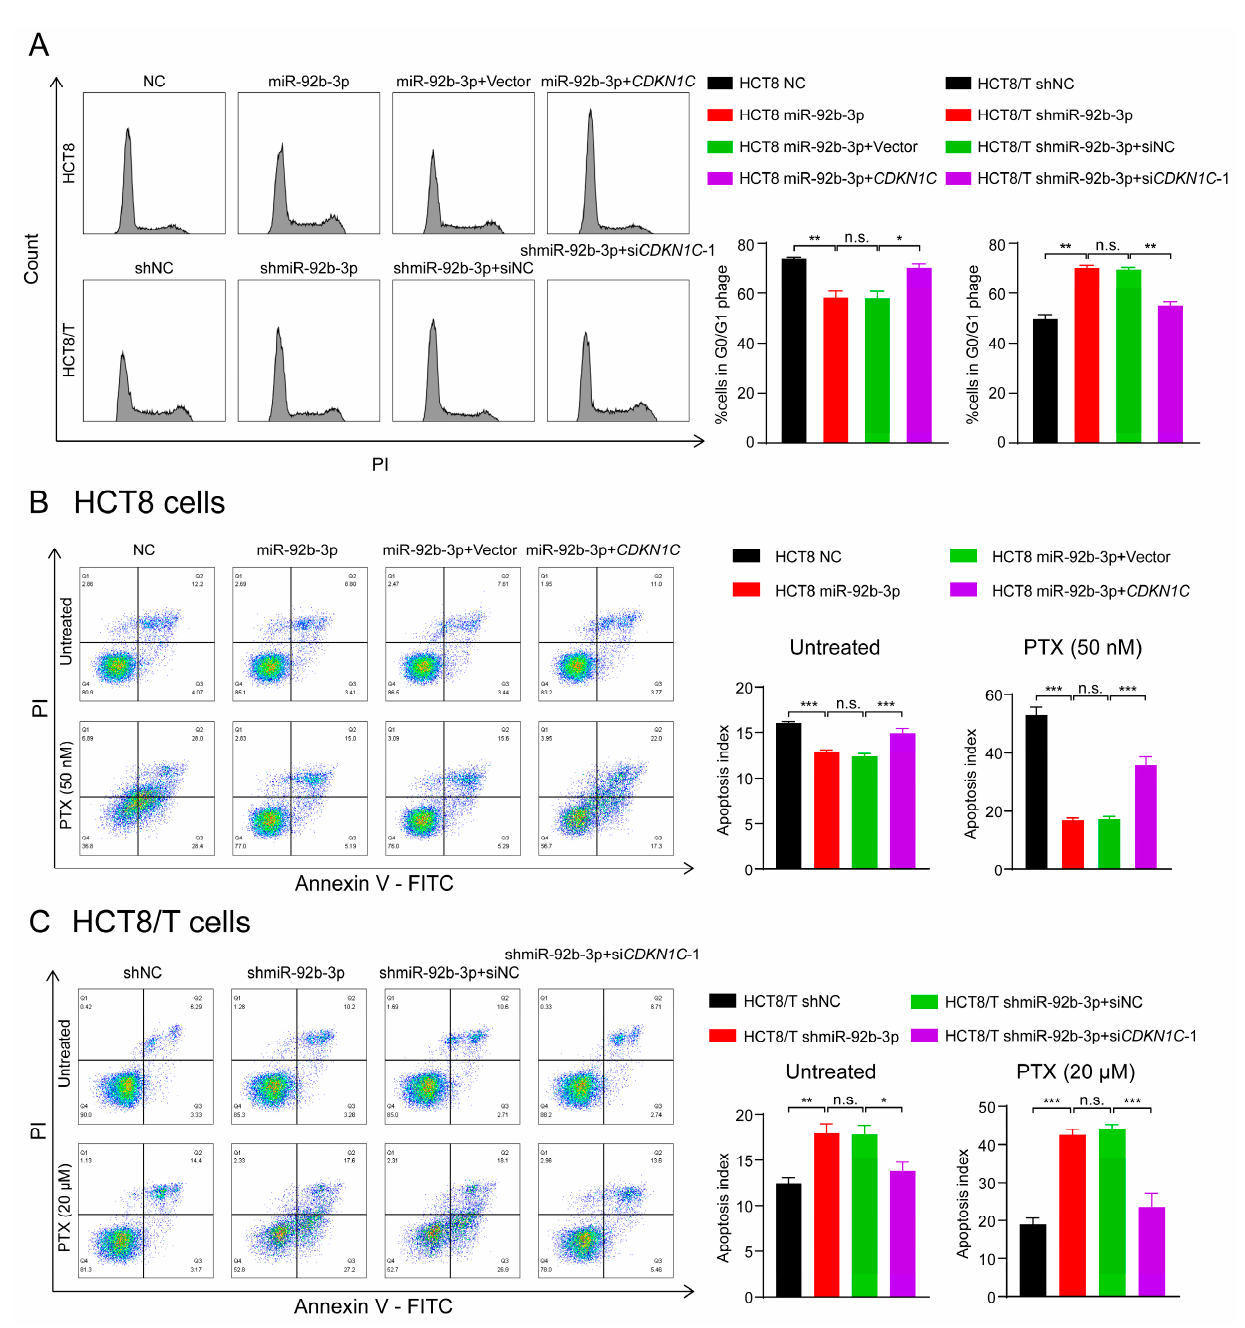
Figure 6. The miR-92b-3p/ CDKN1C axis mediates the sensitivity of HCT8 and HCT8/T cells to chemotherapeutic drugs through regulating cell cycle and apoptosis. ( A ) miR-92b-3p reduces G1 phase arrest in HCT8 and HCT8/T cells by targeting CDKN1C . Cell cycle distribution of HCT8 cells transfected with miR-92b-3p or co-transfected with miR-92b-3p and CDKN1C , and HCT8/T cells transfected with shmiR-92b-3p or co-transfected with shmiR-92b-3p and si CDKN1C-1 by flow cytometry. ( B , C ) miR-92b-3p contributes to reduction of cell apoptosis in the chemotherapy setting by targeting CDKN1C . 24 h after transfection, HCT8 cells were treated with PTX (50 nM) for another 24 h, HCT8/T cells were treated with PTX (20 µ M) for another 24 h. Apoptosis detection was measured by an Annexin-V apoptosis detection kit. All experiments above were repeated three or more times independently and values are shown as mean ± SD. n.s. p > 0.05; * p < 0.05; ** p < 0.01; *** p <